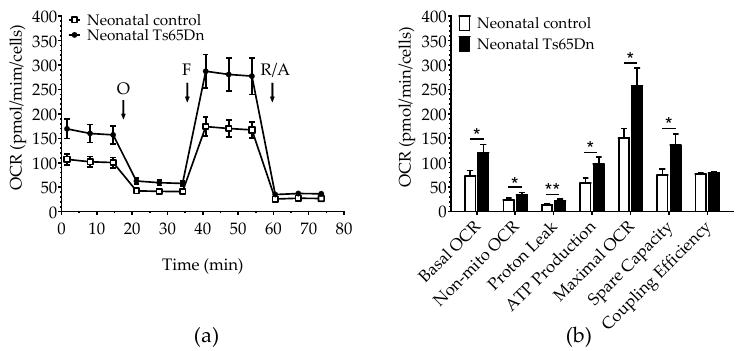
Figure 2. Oxygen consumption in astrocytes derived from neonatal Ts65Dn and control mice. ( a ) Real-time changes in oxygen consumption rate (OCR) after treatment with oligomycin (O), FCCP (F), and rotenone/antimycin A (R/A) ( b ) Individual parameters derived from OCR profiles.